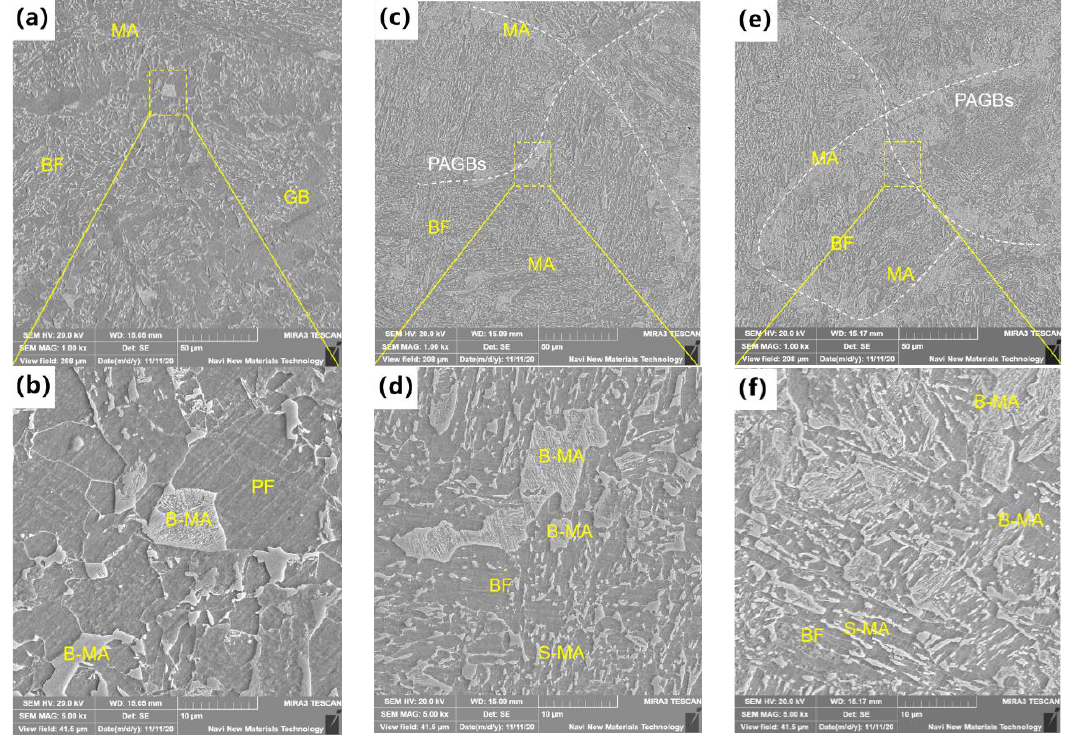
Figure 3. Microstructure of ICR CGHAZ observed by SEM: ( a , b ) CR1, ( c , d ) CR2, ( e , f )